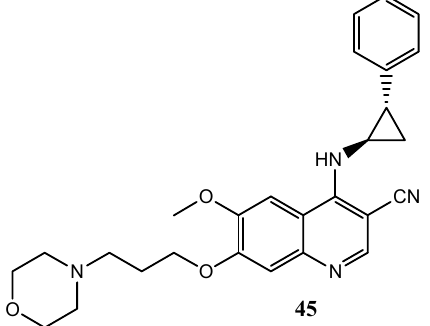
Figure 21. Structure of 4-(2-aryl-cyclopropylamino)-quinoline-3-carbonitrile as selective inhibitor of EGFR [118].